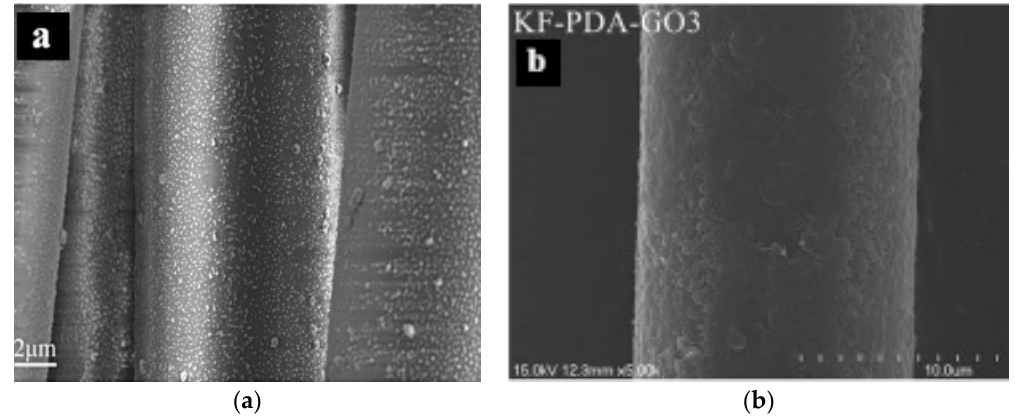
Figure 4. The appearance of ( a ) pizza-like shape memory polyurethane (SMPU)/SiO 2 hybrid coating [63] and ( b ) polydopamine-graphene oxide (GO) hybrid coating [80]. Reprinted with permission from ref 63 and ref 80. Copyright 2014 & 2017 Elsevier.